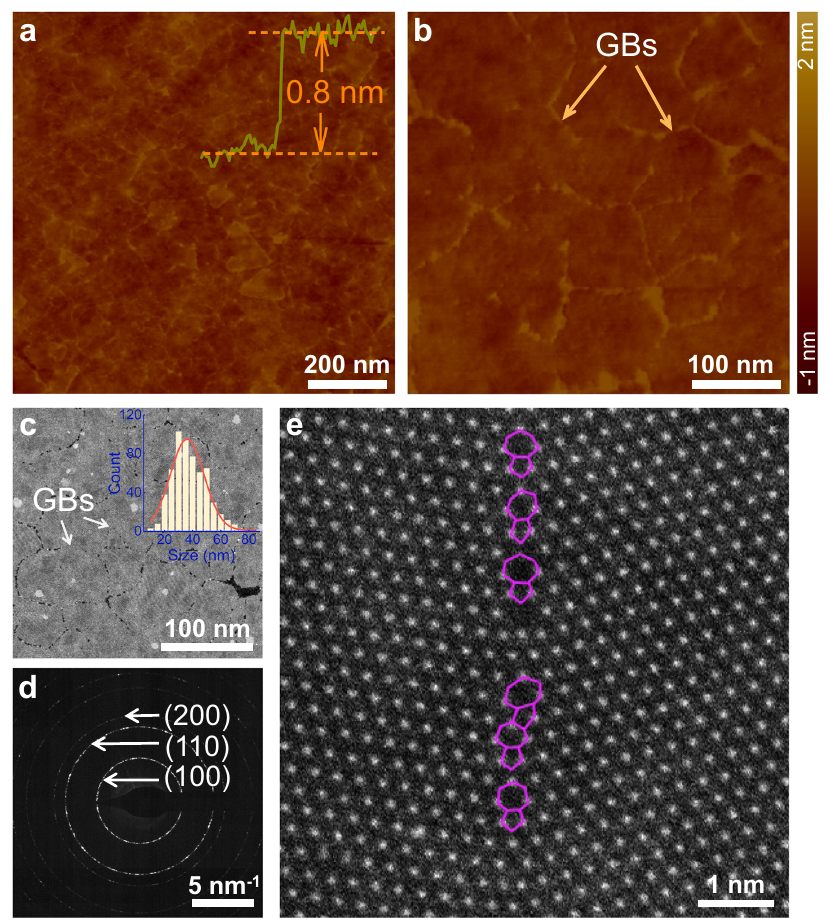
Fig. 1 Characterization of grain boundaries (GBs) in CVD-grown polycrystalline 1L WS 2 fi lm. a , b AFM images of low and high magni fi cations. The height pro fi le was taken from a dash line as shown in Supplementary Fig. 5c. c , d Low-magni fi cation HAADF-STEM image and SAED pattern of as-grown polycrystalline 1L WS 2 fi lm. Inset in c is the distribution of grain sizes. e Atomic scale HAADF-STEM image of a typical GB in the polycrystalline 1L WS 2 fi lm, primarily composed of 5|7 rings (purple